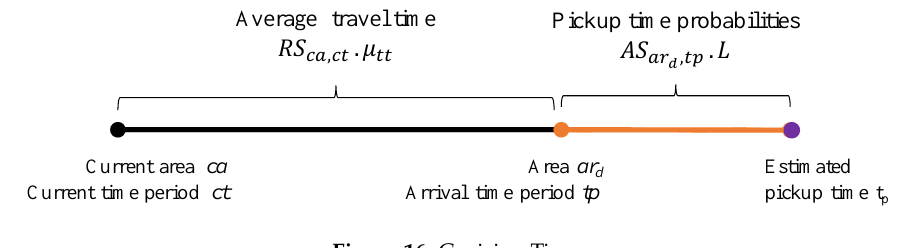
Figure 16. Cruising